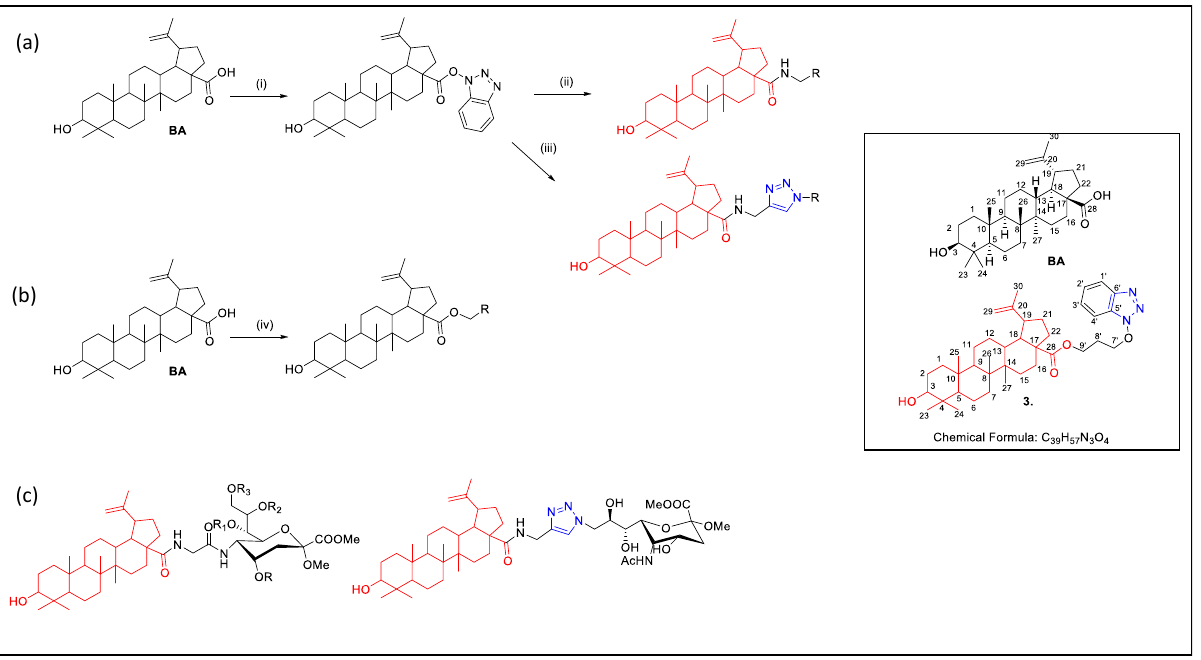
Figure 1. Synthesis of betulinic acid (BA) derivatives: ( a ) ( i ) TBTU, DIPEA, THF ( ii ) amine, K 2 CO 3 , DMF, 1h; ( iii ) CuSO 4 , Na ascorbate, THF- water and ( b ) ( iv ) halogen derivatives, DMF, K 2 CO 3 ; ( c ) Example of betulinic acid derivatives [30,31]); Square: structure of BA and compound 3 reported in this